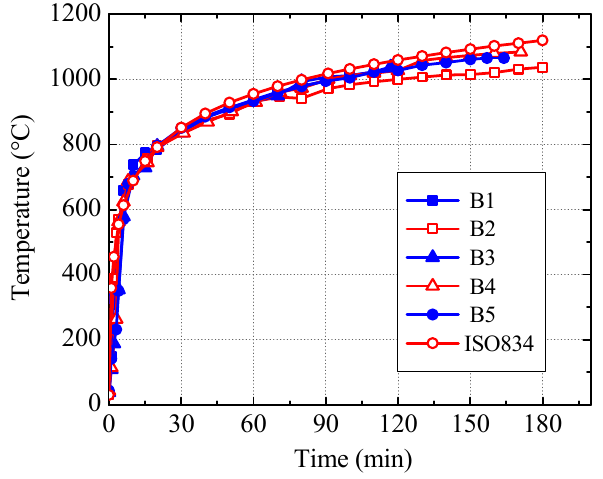
Figure 14. Comparison of measured temperature-time curves in the furnace chamber with an ISO834 standard temperature-time curve.